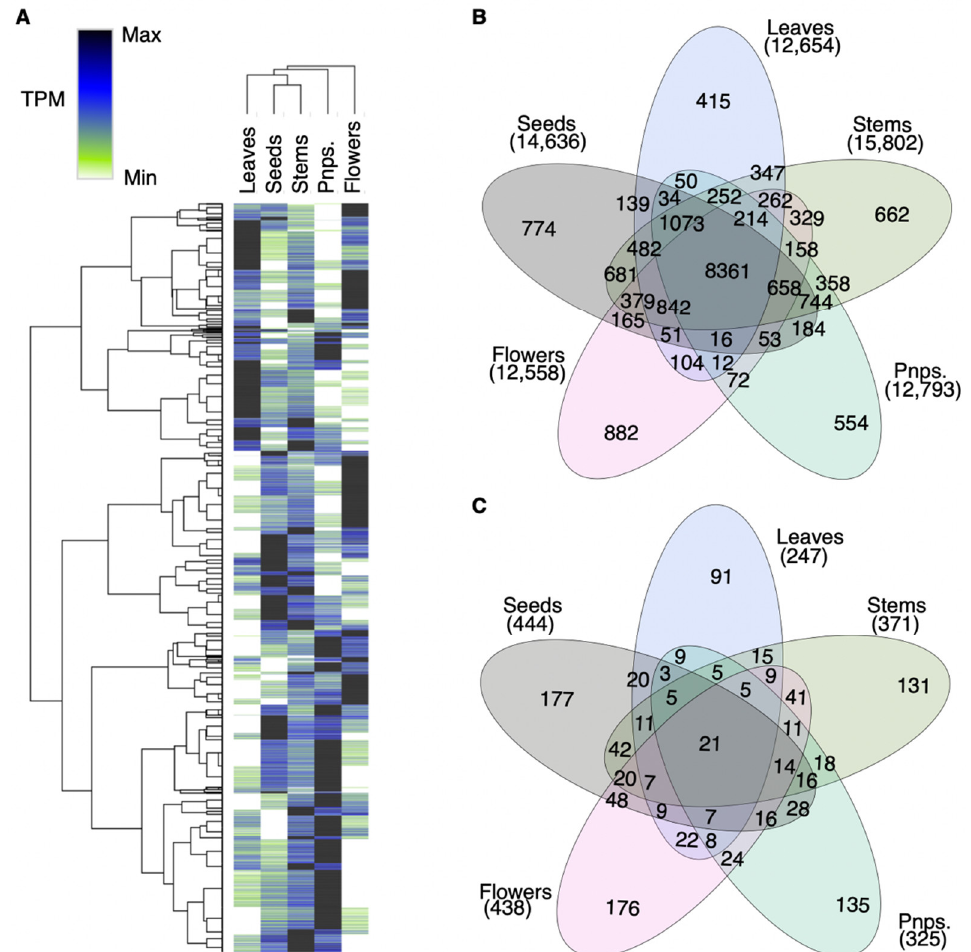
Figure 2. Segregation of Red Sea A. marina gene clusters based on tissue-specific expression patterns. Pnps. = Pneumatophores. ( A ) Hierarchical bi-clustering of transcripts-per-million (TPM) normalized read counts from the five mangrove tissues using Pearson’s correlation (see Table S1). The y-axis indicates transcripts. Darker clusters in each tissue correspond with GO enrichment networks. ( B ) Venn diagram showing reference transcripts > 10 TPM from five tissues. Leaves had the smallest unique set, while stems expressed the most transcripts > 10 TPM. Figure S2 shows additional intersections not shown here. ( C ) Unique and shared KEGG Orthology (KO) in the unique gene sets from ( B ). Approximately 60% of KOs from the uniquely expressed genes in each tissue are shared with one or more other tissues. Nearly one-third of ( C ) KOs in any given tissue are unique to that tissue, while the ratio of unique ( B ) transcripts is 1/15th the expressed transcript count. This discrepancy suggests a high redundancy in function coded for by A. marina transcripts.